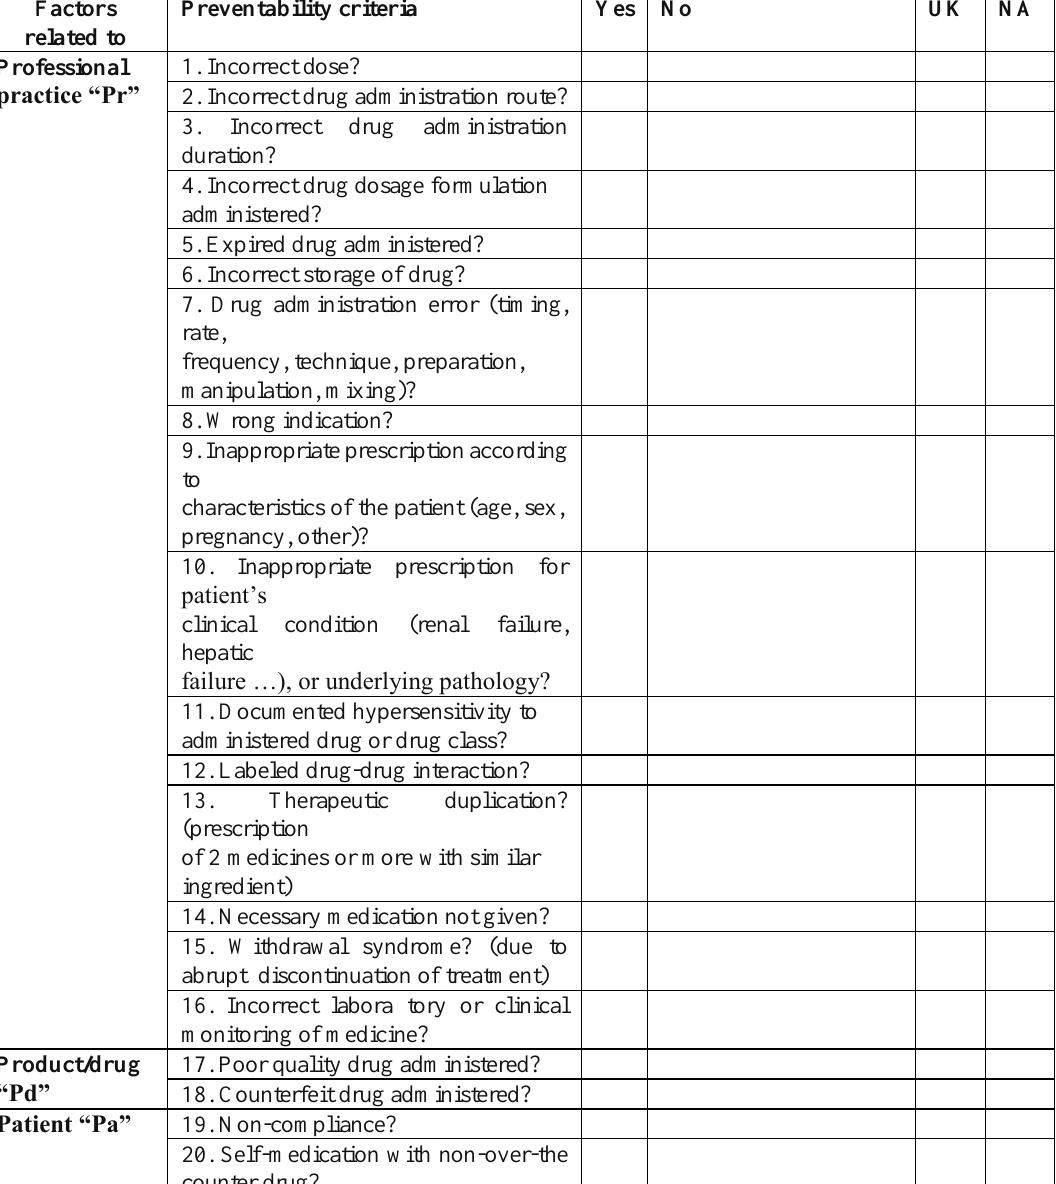
Table 1. Criteria for the assessment of the preventability of ADEs (1) . Factors related to